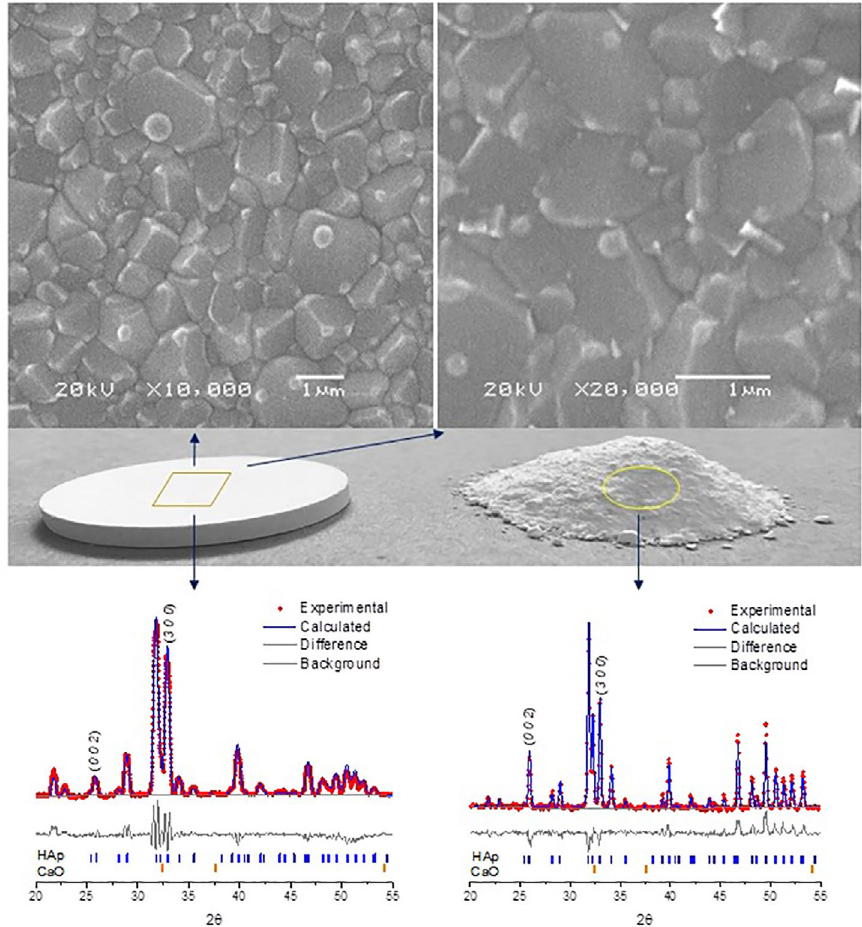
Figure 2. Macro images of pellets obtained after pressing/calcination and in powder form after grinding. Details on the pellet surfaces can be observed in scanning electron microscopy (SEM) images at different magnifications. The crystallographic parameters of both the surface and bulk materials can be compared in X-ray diffraction (XRD) patterns. Rietveld parameters: GoF 1.45 (left), GoF 2.16 (right). on the surface and in the bulk have remarkably different crystallographic